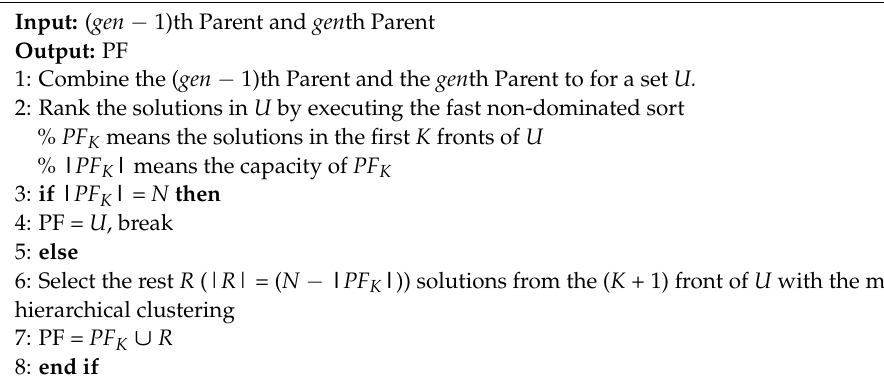
Algorithm 1: Merged hierarchical clustering-based determination of